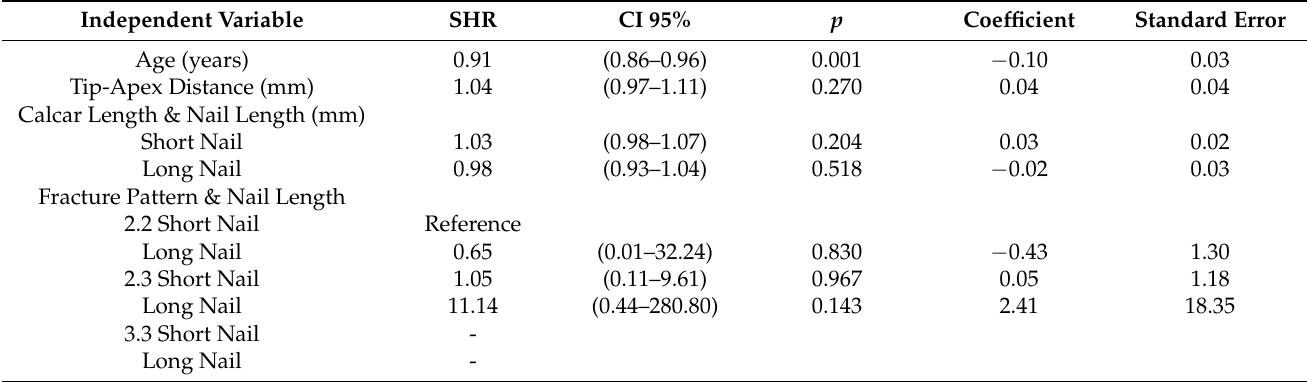
Table 3. Multivariate predictors of